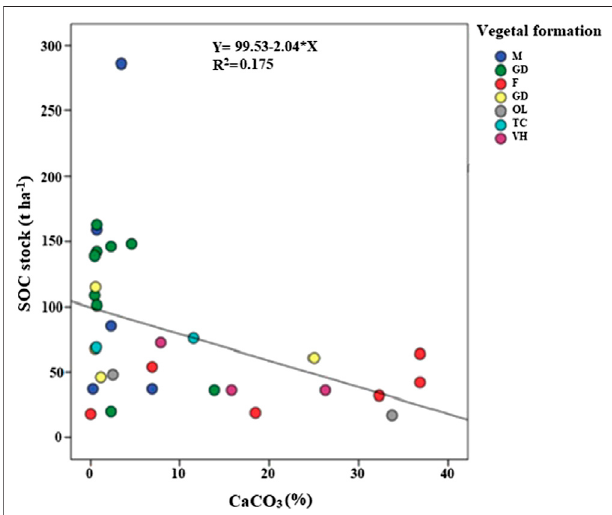
FIGURE 3 | Correlation between soil carbonates (CaCO3) and SOC stocks. M: matorral; GC: sparse garrigue; F: forest; GD: dense garrigue; OL: olive grove; TC: oak coppice; VH: herbaceous vegetation.